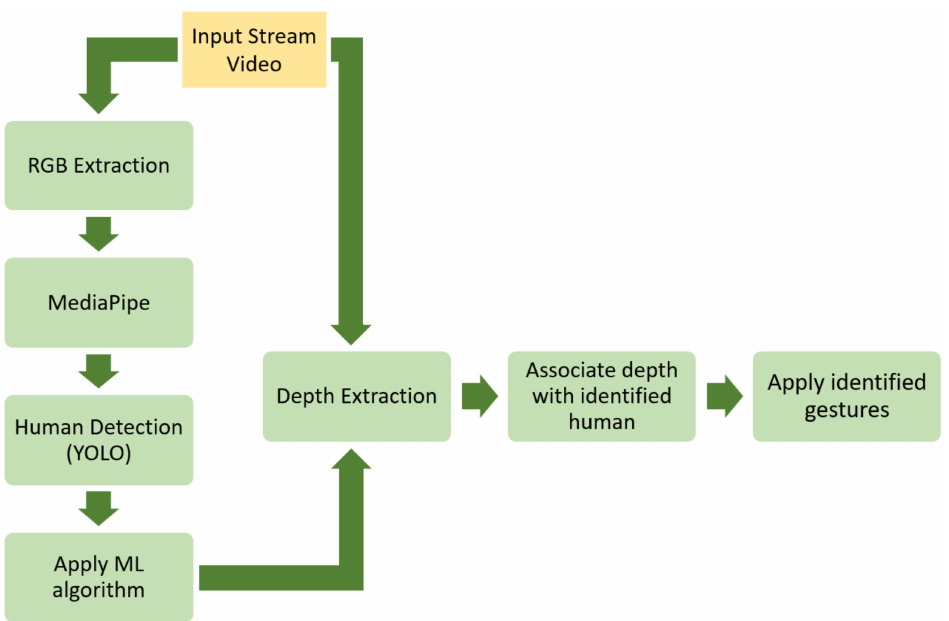
Figure 5. Operation flow of the developed